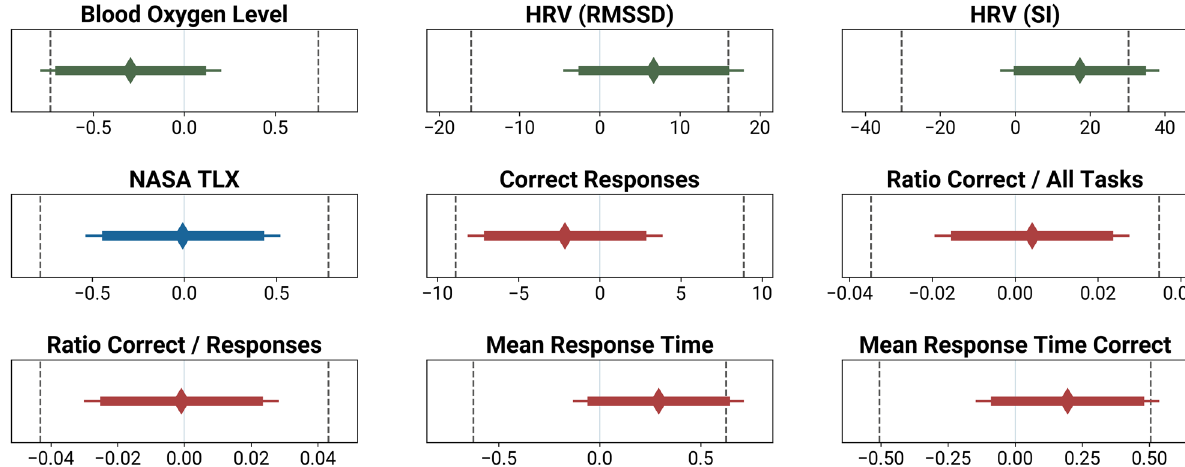
Figure 1. Equivalence boundaries (dotted lines left and right), mean of the mask / no-mask difference (diamond) and the 95% confidence interval (thin line; for the null hypothesis significance test), as well as the 90% confidence interval for the TOST (thick line). The x-axis shows the mean difference in the unit of the